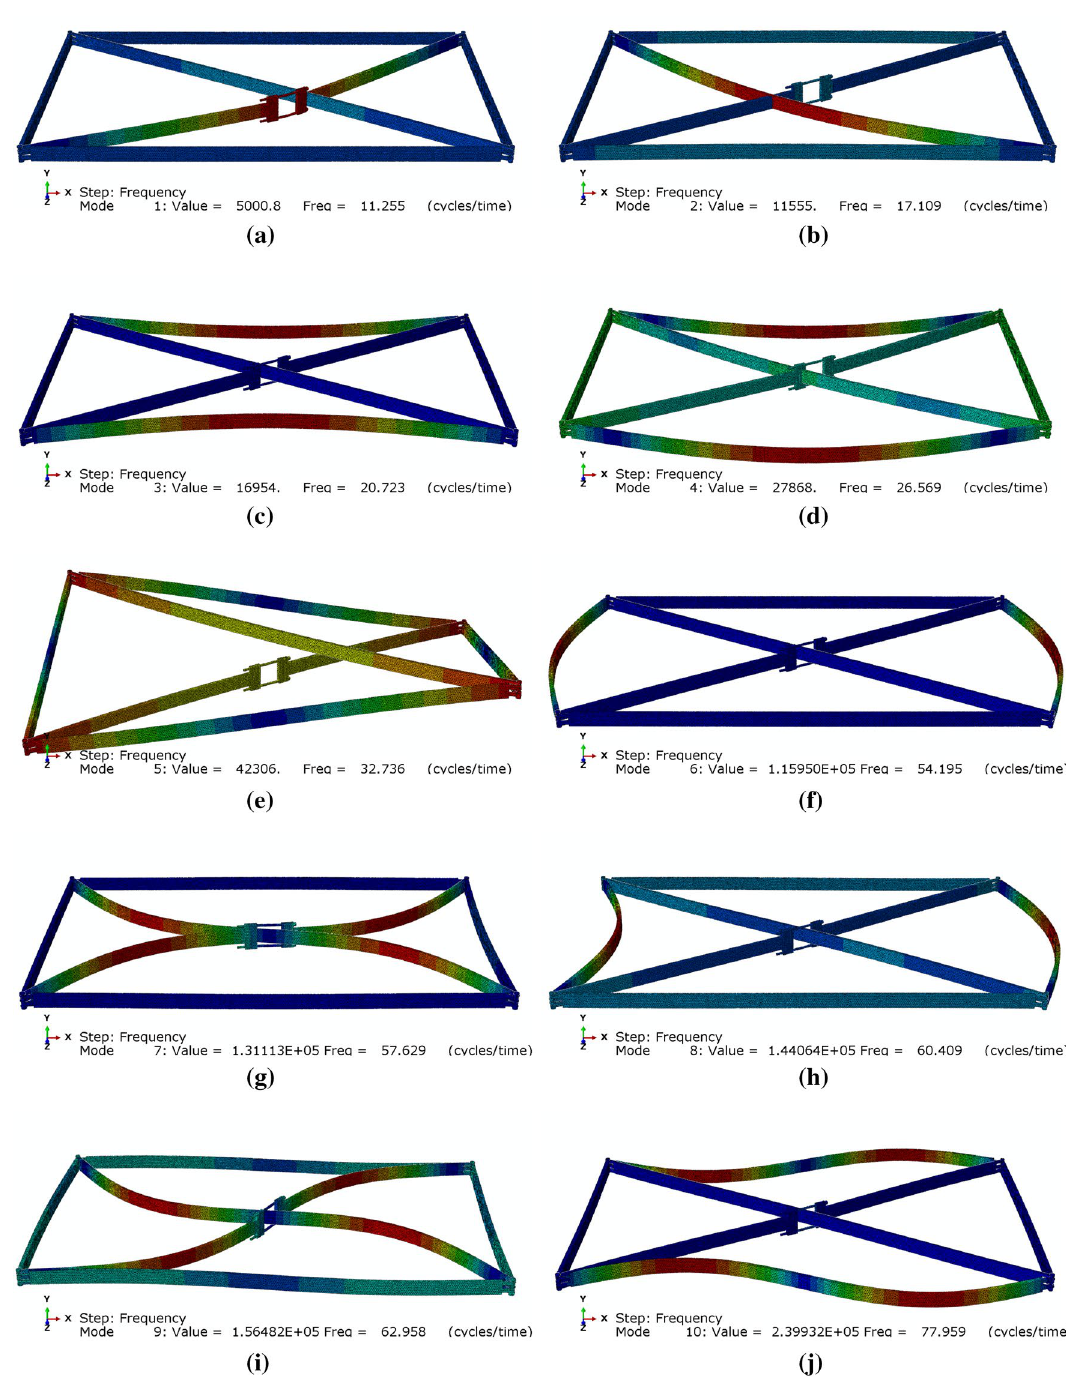
Fig. 15 Mode shapes of the a – j first-10th modes of vibration, FE modal analysis